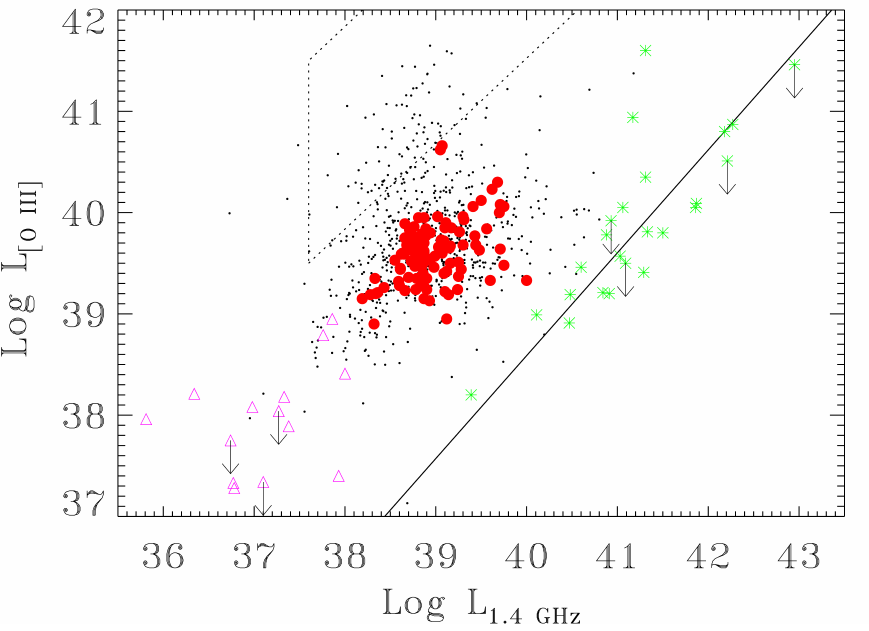
Figure 2. FIRST 1.4-GHz radio vs. [O III] line luminosity (erg s − 1 ). The small points correspond to the low-luminosity RG sample selected by [14]. The solid line represents the correlation between line and radio-luminosity derived for the 3CR/FR I sample (green stars). The dotted lines include the region where radio-quiet Seyfert galaxies are found. The red points are the FR 0 included in the FR0 CAT [29] and the violet triangles are the